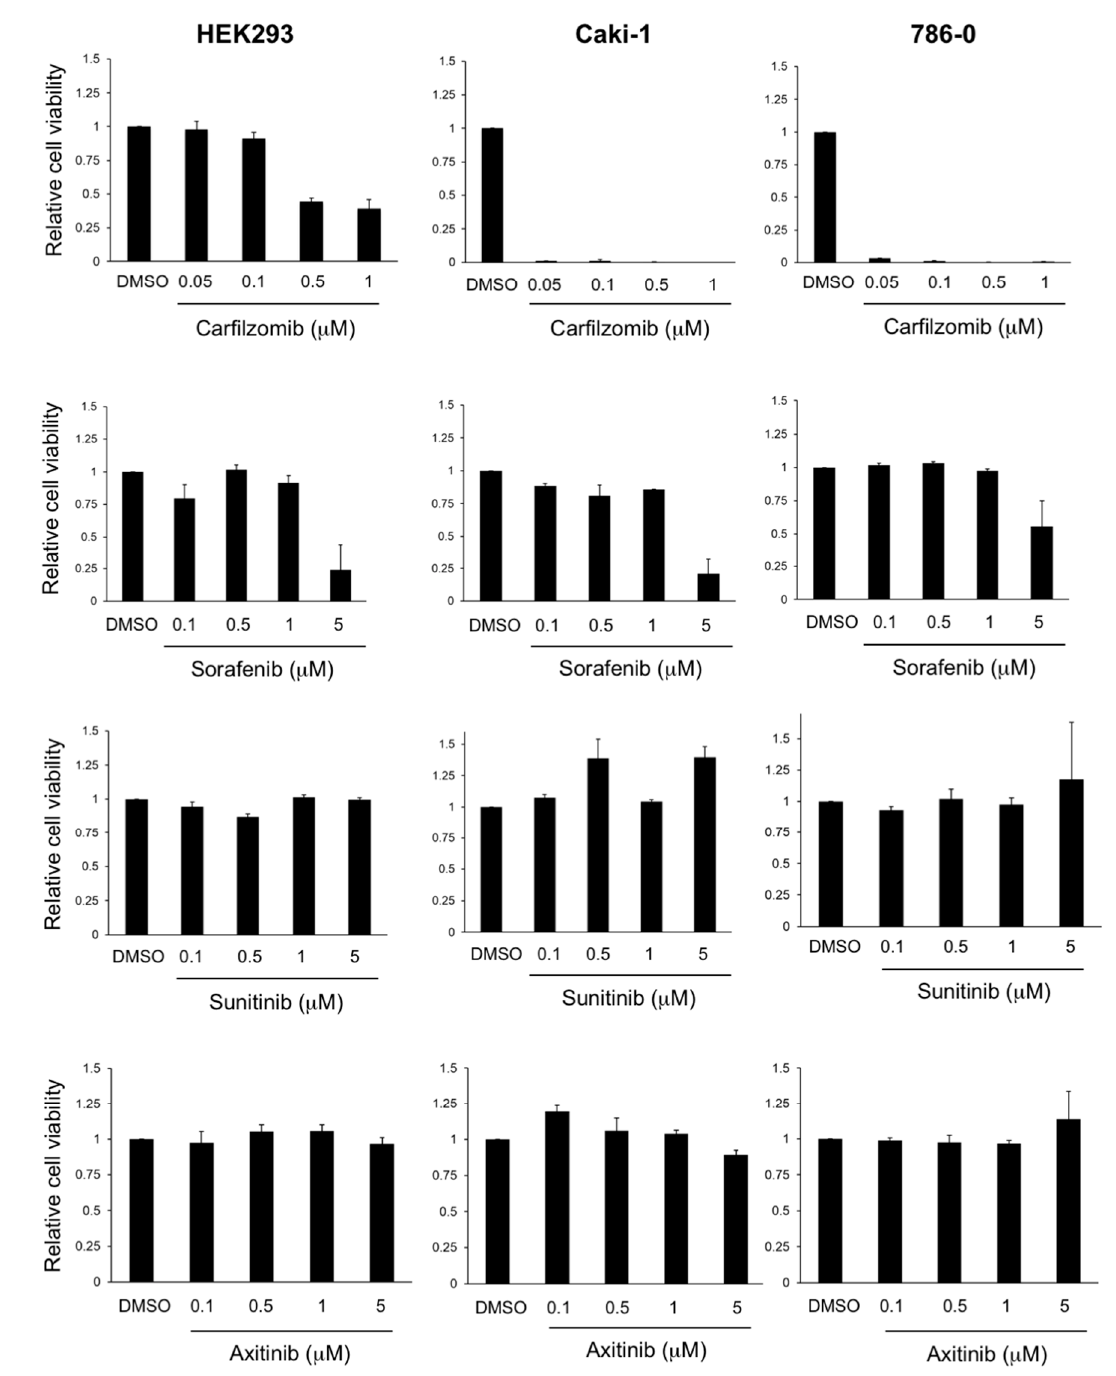
Figure 3. Carfilzomib shows superior in vitro antitumoral activity compared to TKIs. Quantification of cell viability of HEK293, Caki-1 and 786-0 cell lines after treatment with carfilzomib or TKIs at the concentrations indicated for 72 h. Results from three independent experiments (mean ± standard error) are shown after normalization to control (DMSO).